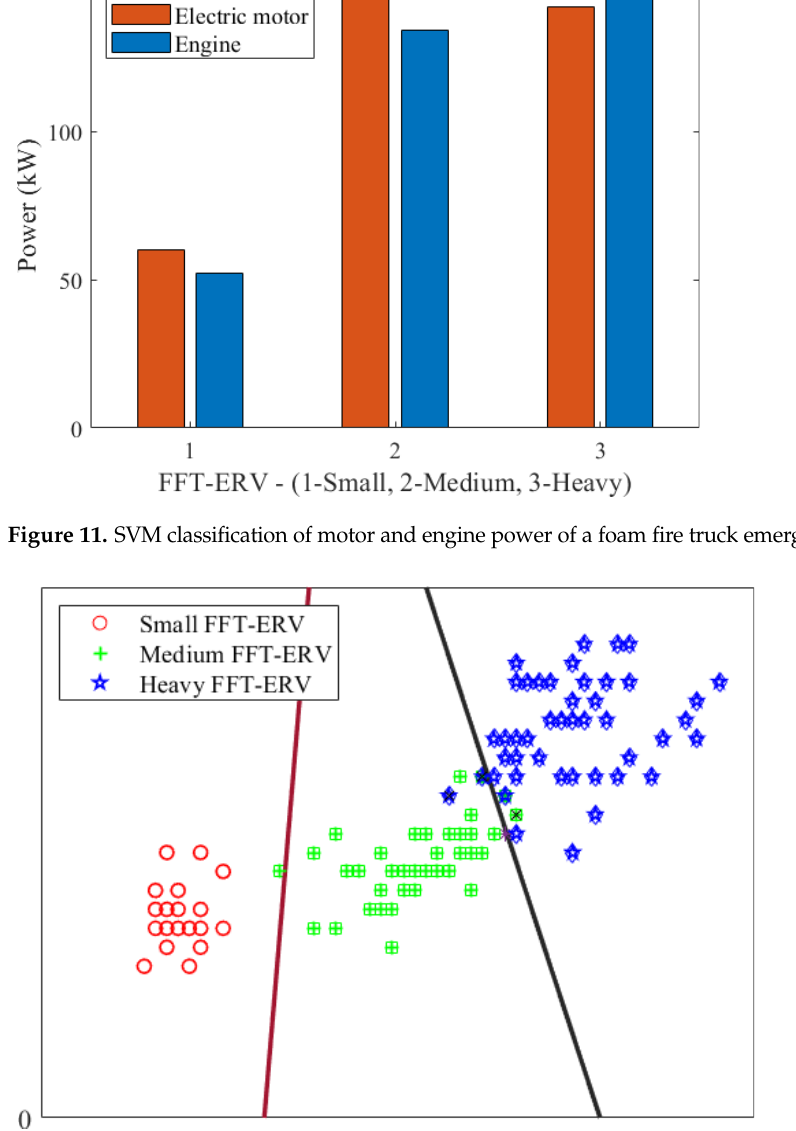
Table 6. SVM classification of emergency rescue vehicle.